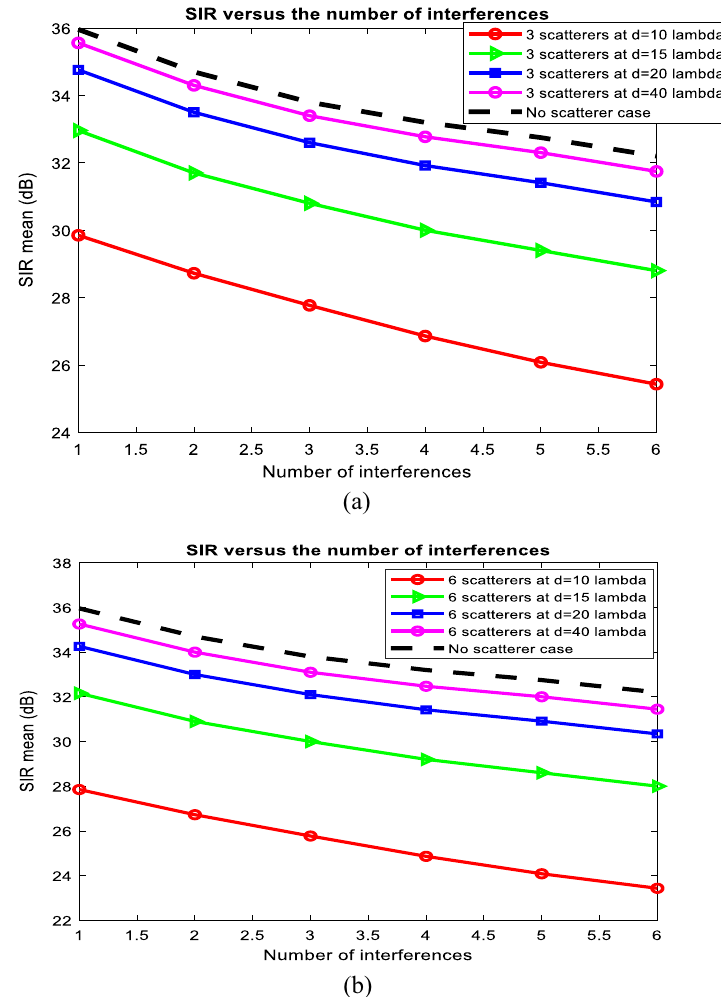
Fig. 14 Mean values of the SIR versus the number of interferences in presence of the scatterers at d = 10 (cid:31) ,15 (cid:31) ,20 (cid:31) ,40 (cid:31) compared to no scatterer case a three large cylindrical scatterers, b six large cylindrical